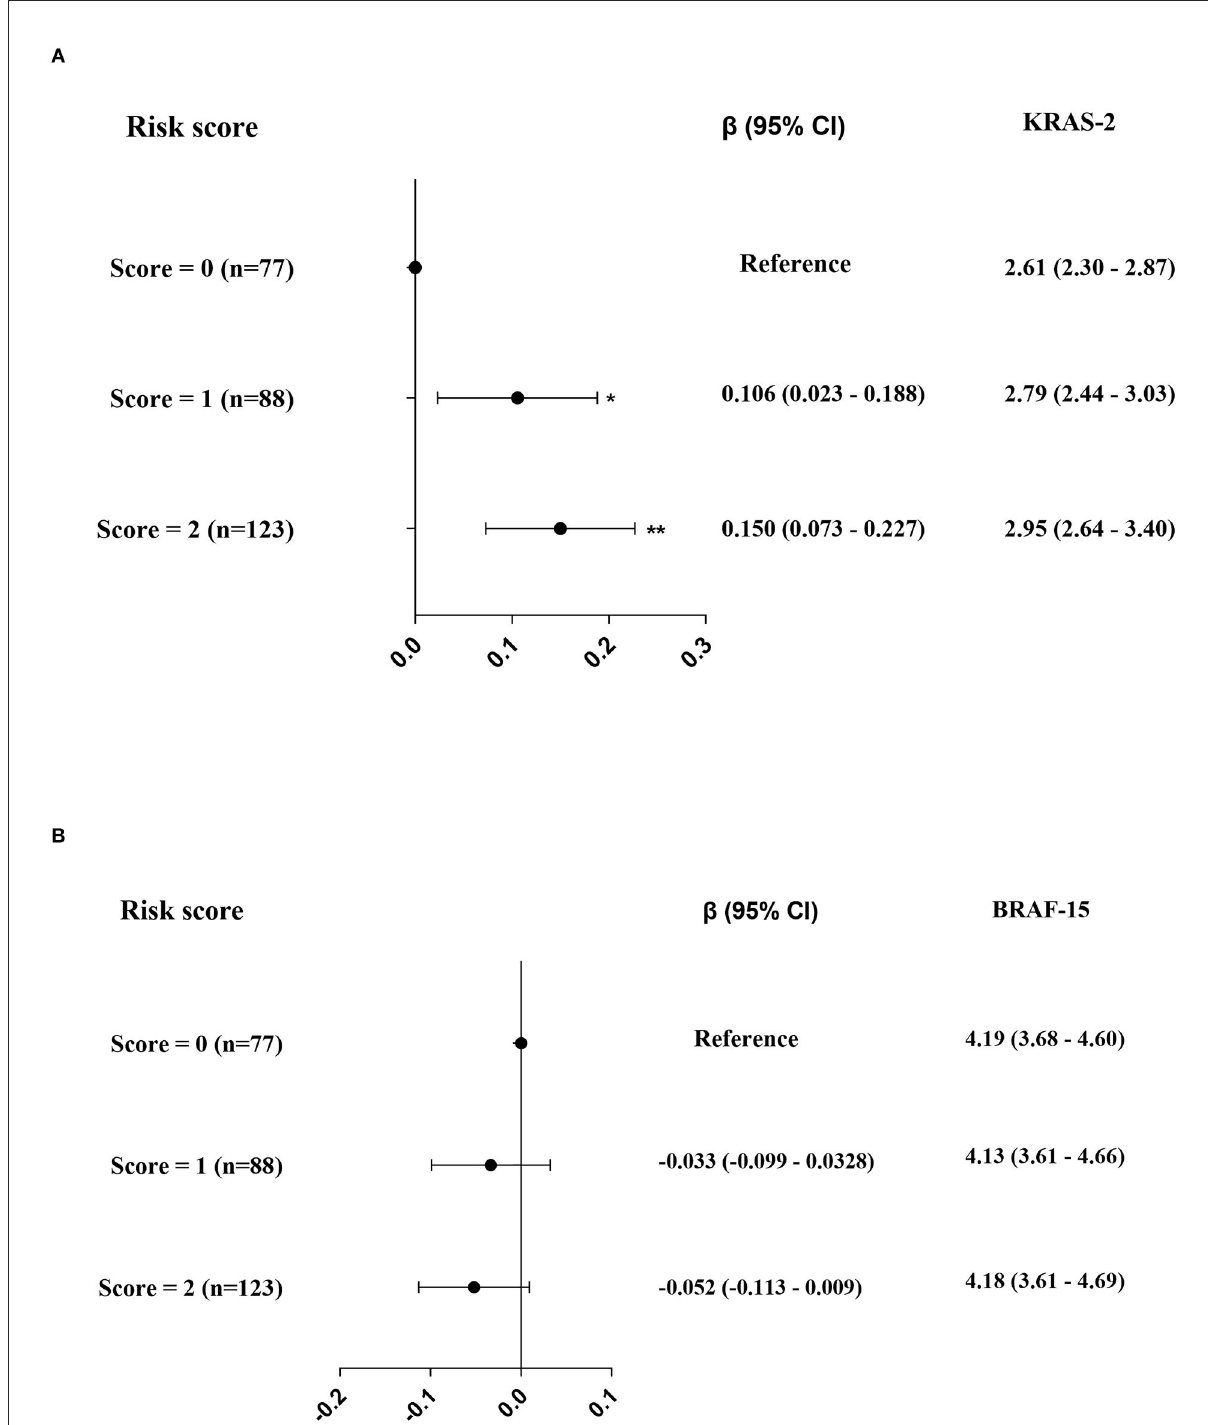
FIGURE3 The effects of rs2228001 GG + GT genotype and/or rs3731055 GG genotype on KRAS-2 (A) and BRAF-15 (B) respectively. Note: The black solid dot and black line in panels represent a (95% CI), while the levels of KRAS-2 and BRAF-15 are represented as median (25th, 75th percentiles). * p < 0.025; ** p <